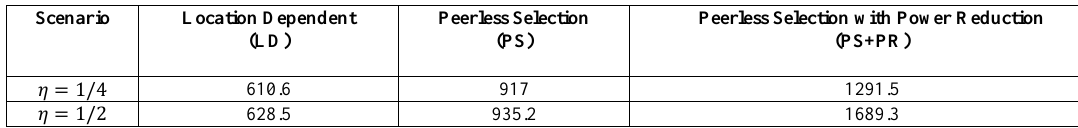
Table 1. Throughput Comparison between different schemes under different